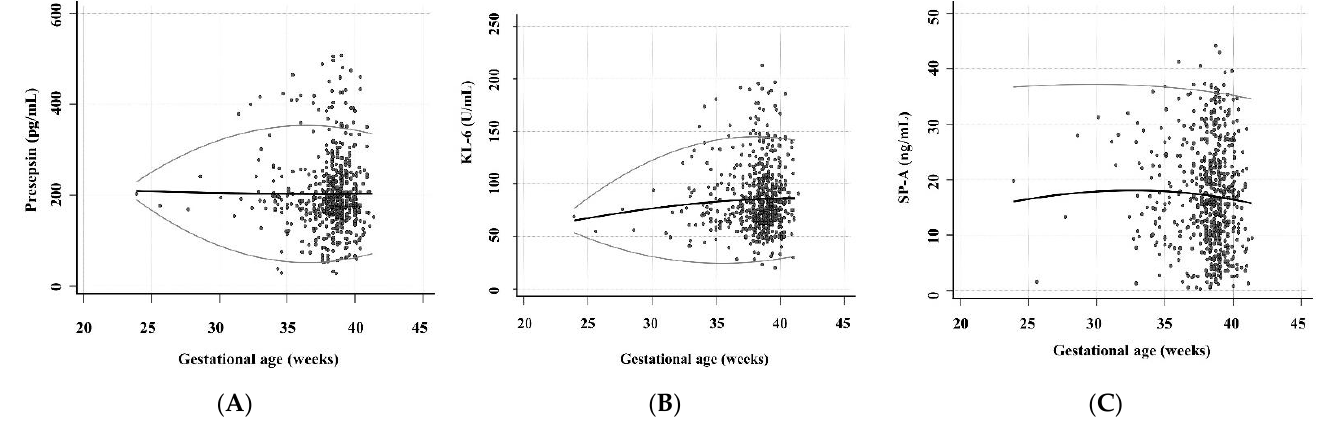
Figure 2. The levels of presepsin, KL-6, and SP-A according to the GA ( n = 576 in presepsin, n = 601 in KL-6, and n = 609 in SP-A). These scatter diagrams show the levels of ( A ) presepsin, ( B ) KL-6, and ( C ) SP-A according to the GA. The black central line indicated the median level and the gray curved line indicated 2.5th to 97.5th centile RIs. Abbreviations: KL-6, Krebs von den Lungen 6; SP-A, surfactant protein A; UCB, umbilical cord blood; GA, gestational age.